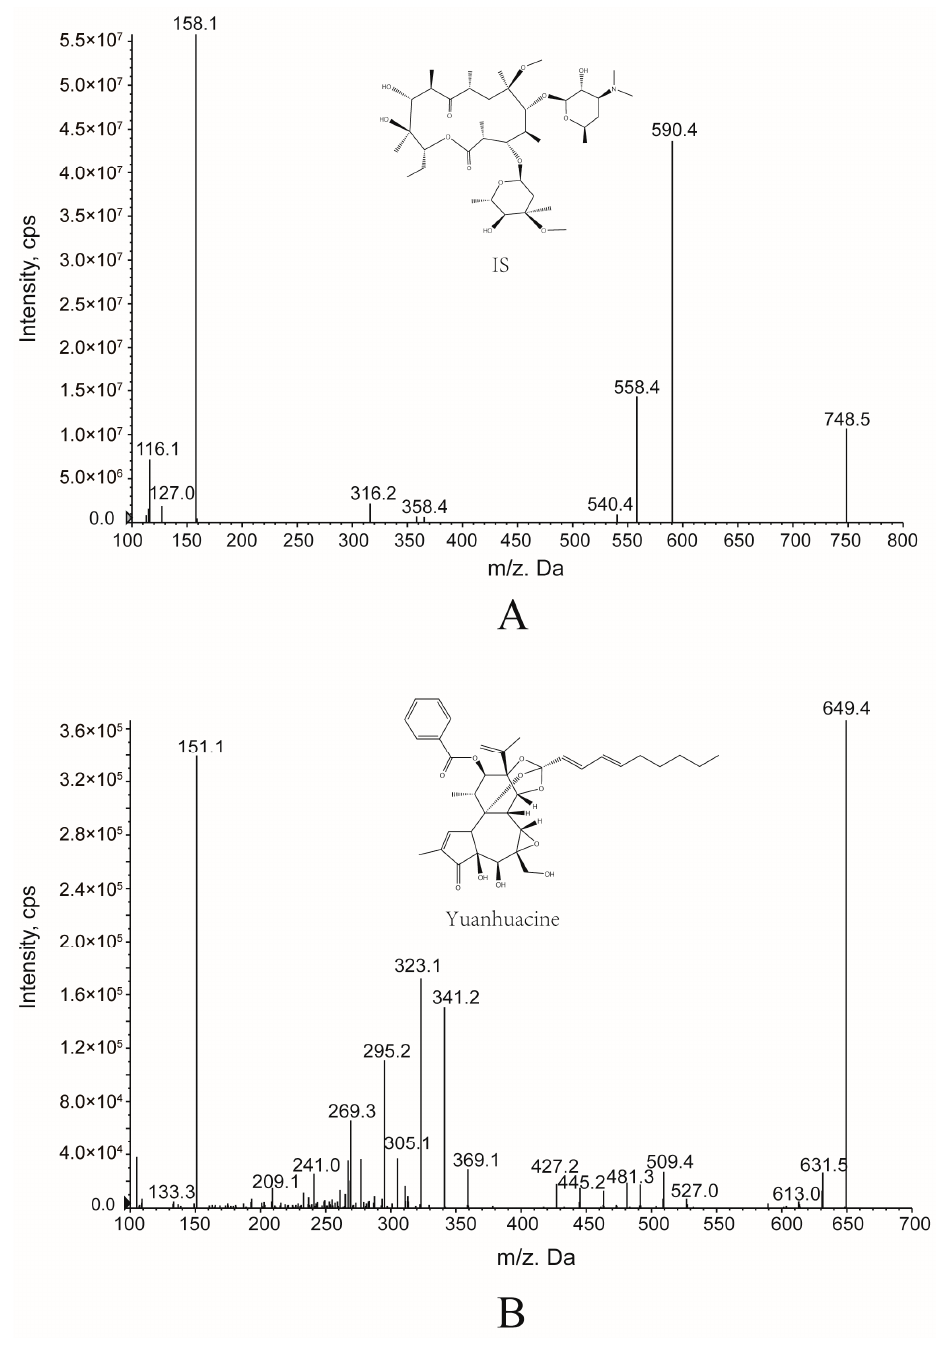
Figure 4. Mass spectra for IS ( A ) and yuanhuacine ( B ) detection.